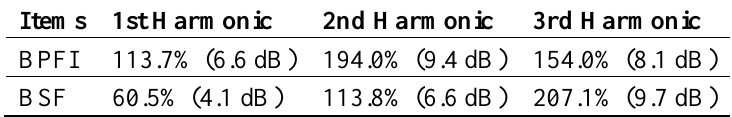
Table 3. The enhancement in amplitude by proposed TLEOA